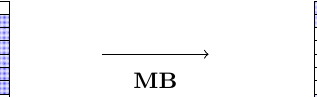
Figure 6: Differential through a MixBytes